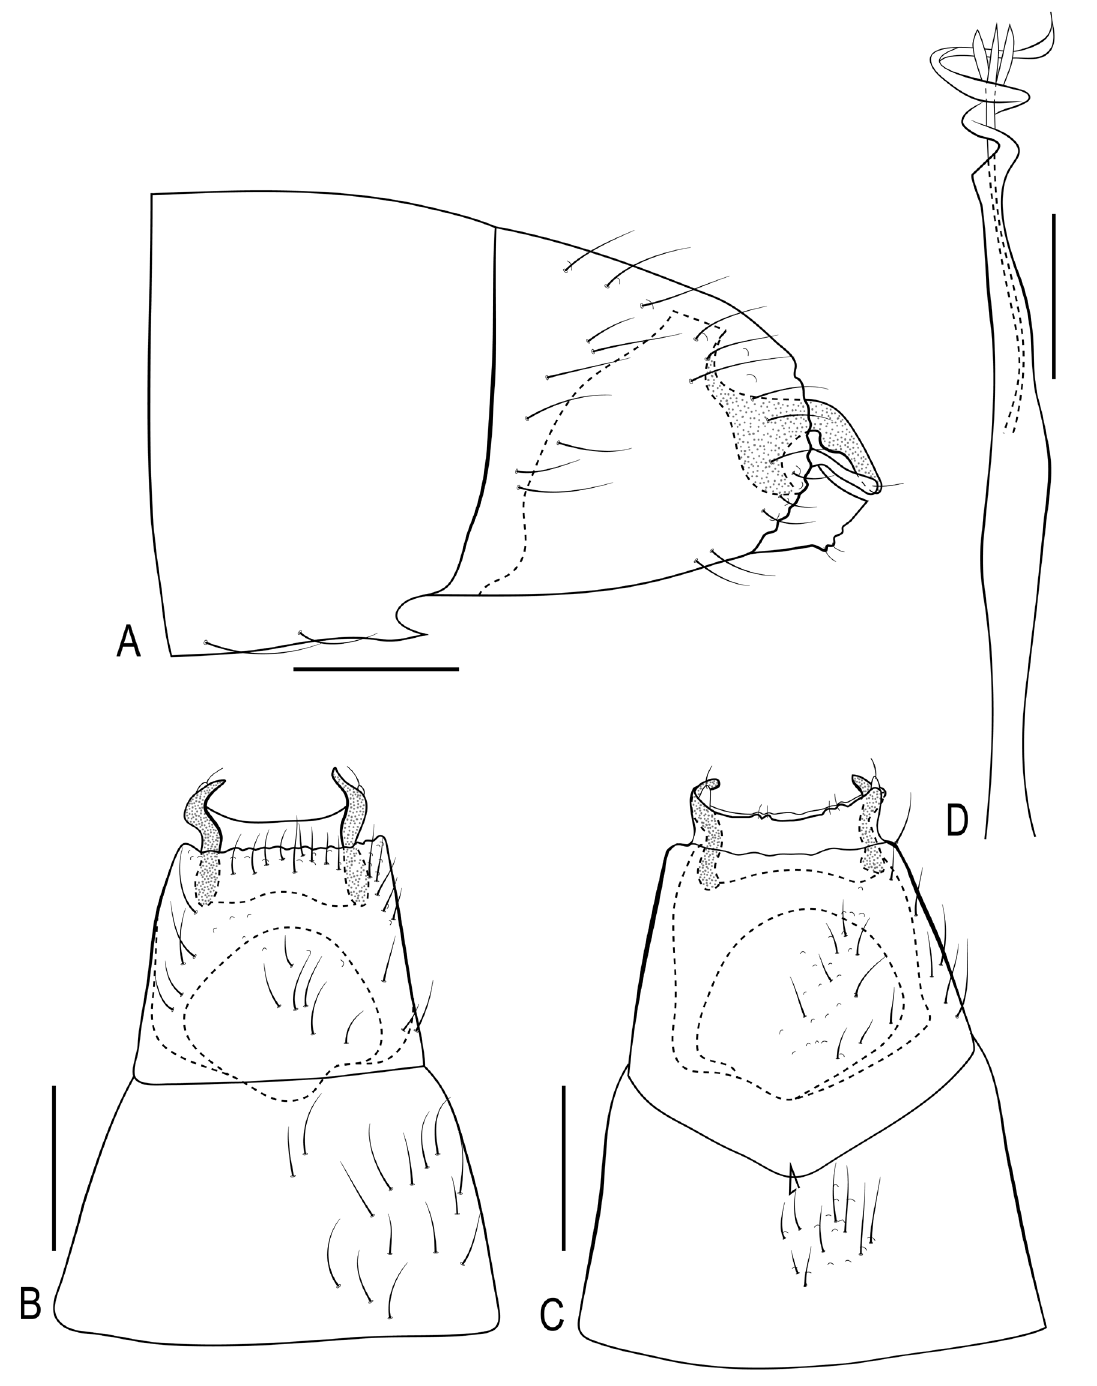
Fig. 3. Oxyethira ( Trichoglene ) spiralis sp. nov., male genitalia. A . Lateral. B . Dorsal. C . Ventral. D . Aedeagus, dorsal. Scale bars = 0.1